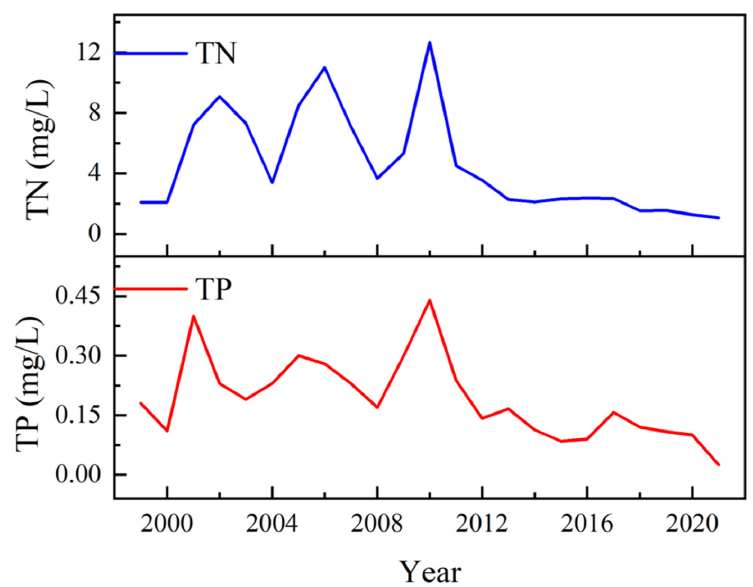
Figure 12. Eutrophication evolution analysis of the long time series of Wuliangsu Lake.